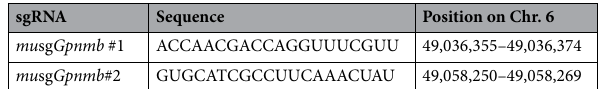
Sequence Position on Chr.